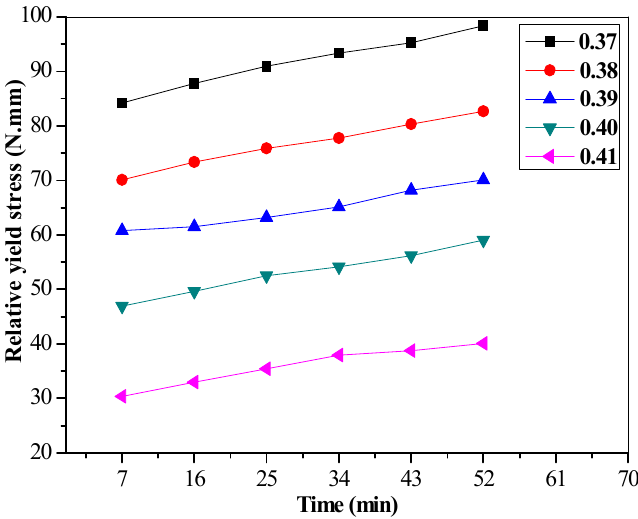
Figure 5. Relative yield stress versus time.